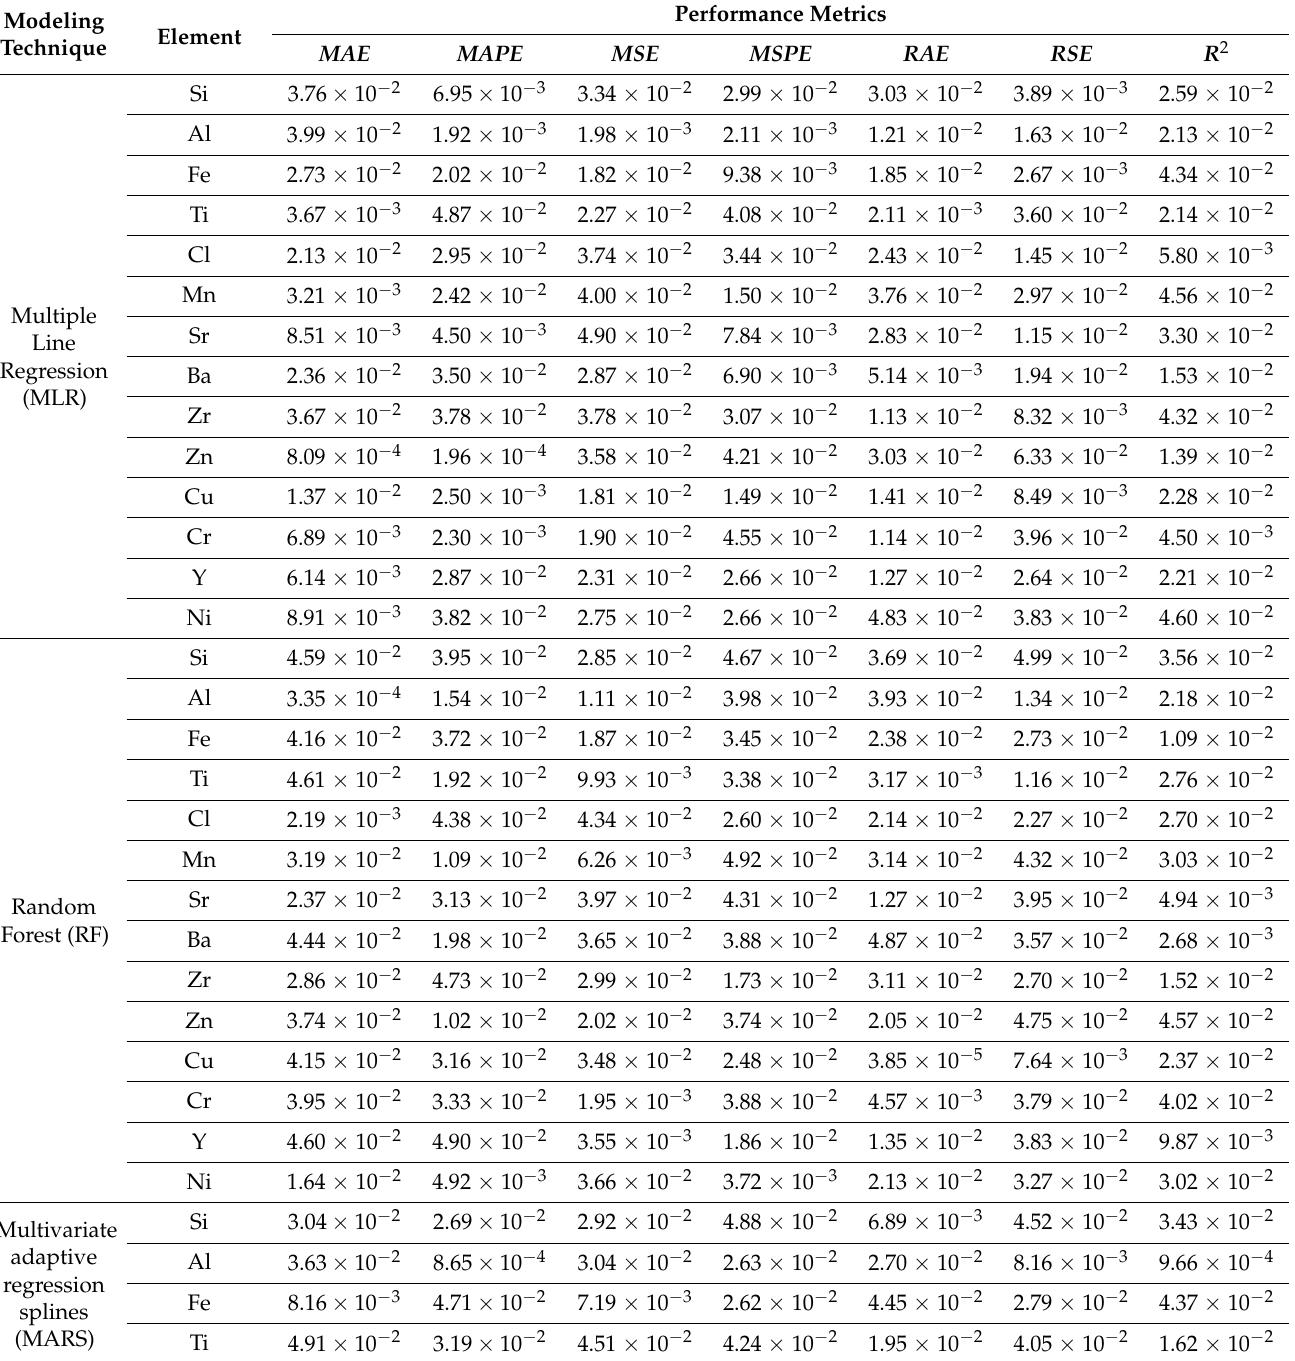
Table 4. Comparison between different models using statistical